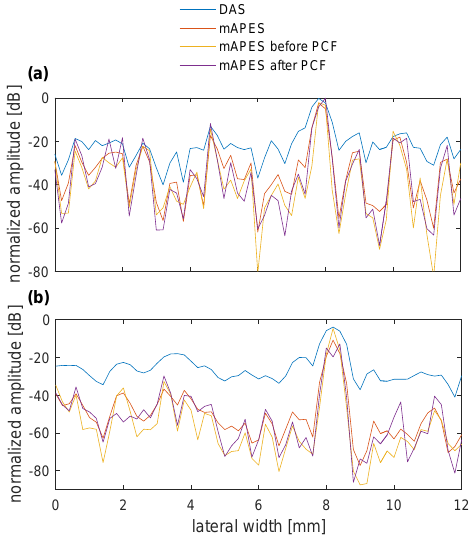
Figure 3. Lateral amplitude profile obtained from point target at axial depths of ( a ) 12 mm and ( b ) 22 mm in Figure